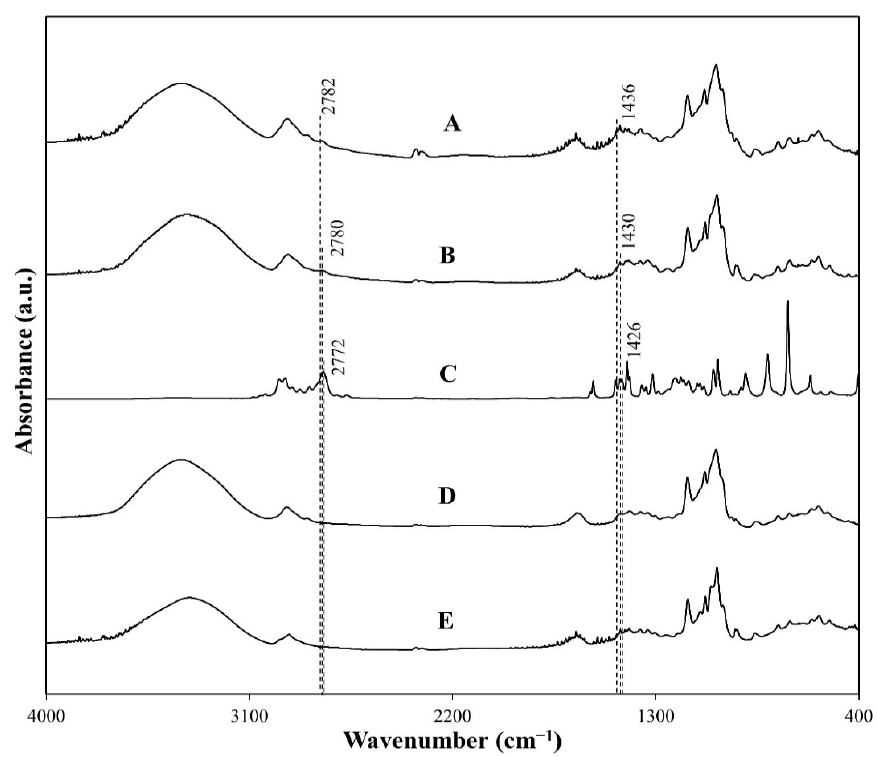
Figure 8. IR spectrum of ( A ) the nicotine/M β CD inclusion complex, ( B ) the nicotine/ β CD inclusion complex, ( C ) nicotine, ( D ) M β CD, and ( E ) β CD. complex, ( C ) nicotine, ( D ) M β CD, and ( E ) β